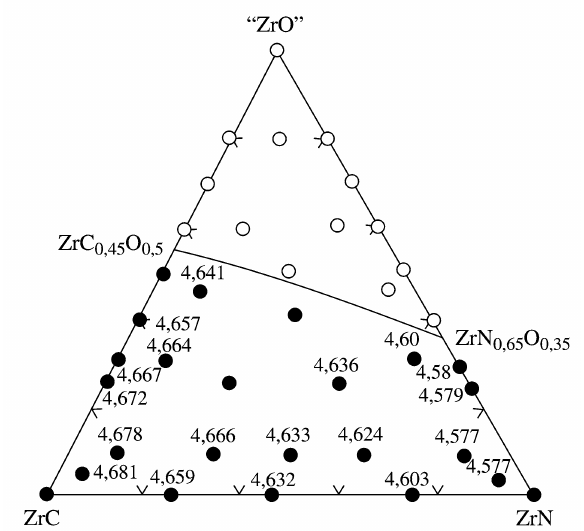
Figure 1. Pseudoternary phase diagram of the "ZrO-ZrN-ZrC" system. The cell parameters of Zr(C,N,O) phases are indicated as: ( • ) monophase zone and ( o ) polyphase